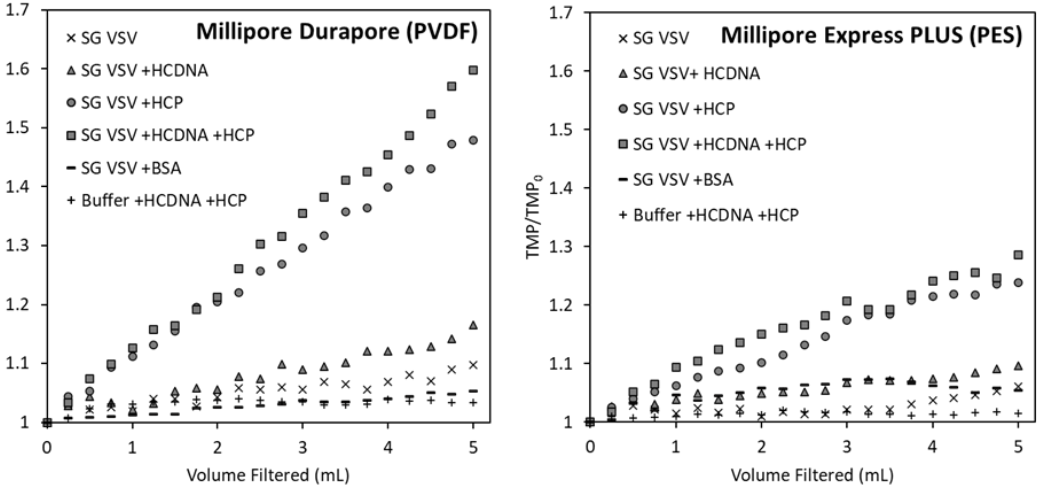
Figure 4. Transmembrane pressure (TMP) profiles (reported as the ratio of the measured TMP to the initial TMP) for the constant flux filtration (0.3 mL min −1 cm −2 ) of five vesicular stomatitis virus (VSV) solutions and one VSV-free solution through the Durapore PVDF 0.22 µm and Express PLUS PES 0.22 µm microfiltration membranes. Data points are the average of the duplicate filtration tests conducted for each solution.